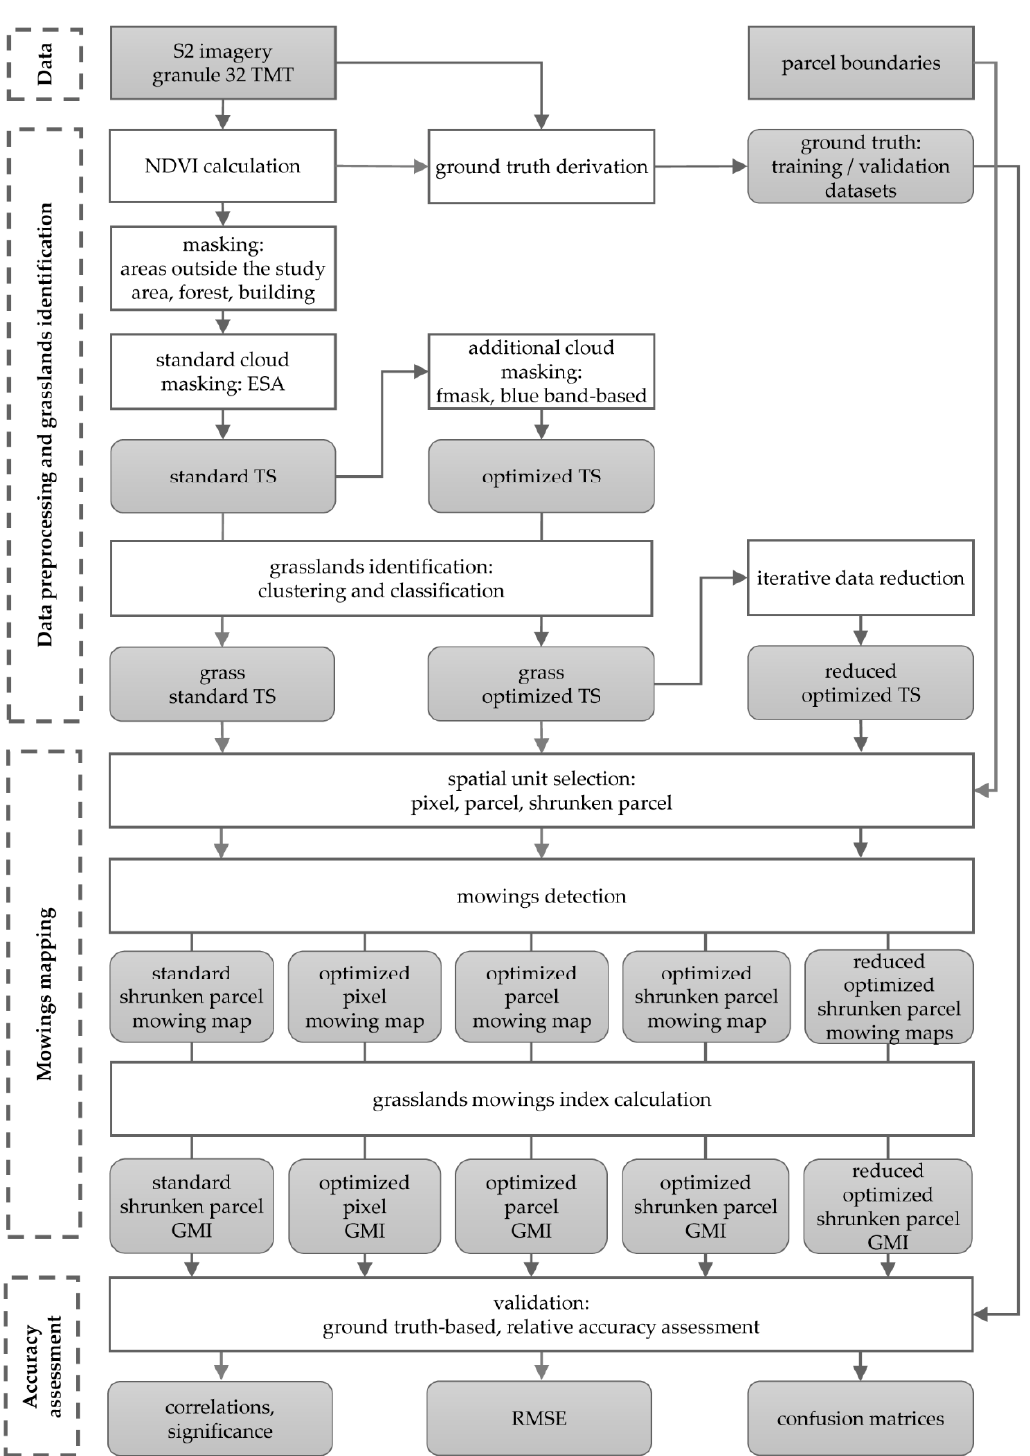
Figure 3. Workflow overview. Sentinel-2 (S2); normalized difference vegetation index (NDVI); European Space Agency (ESA); time series (TS); grasslands mowing index (GMI); root mean square error (RMSE).